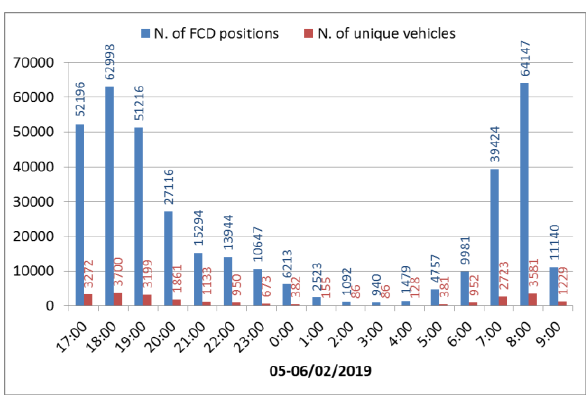
Figure 1. The municipality of Torino (in blue) and its metropolitan area